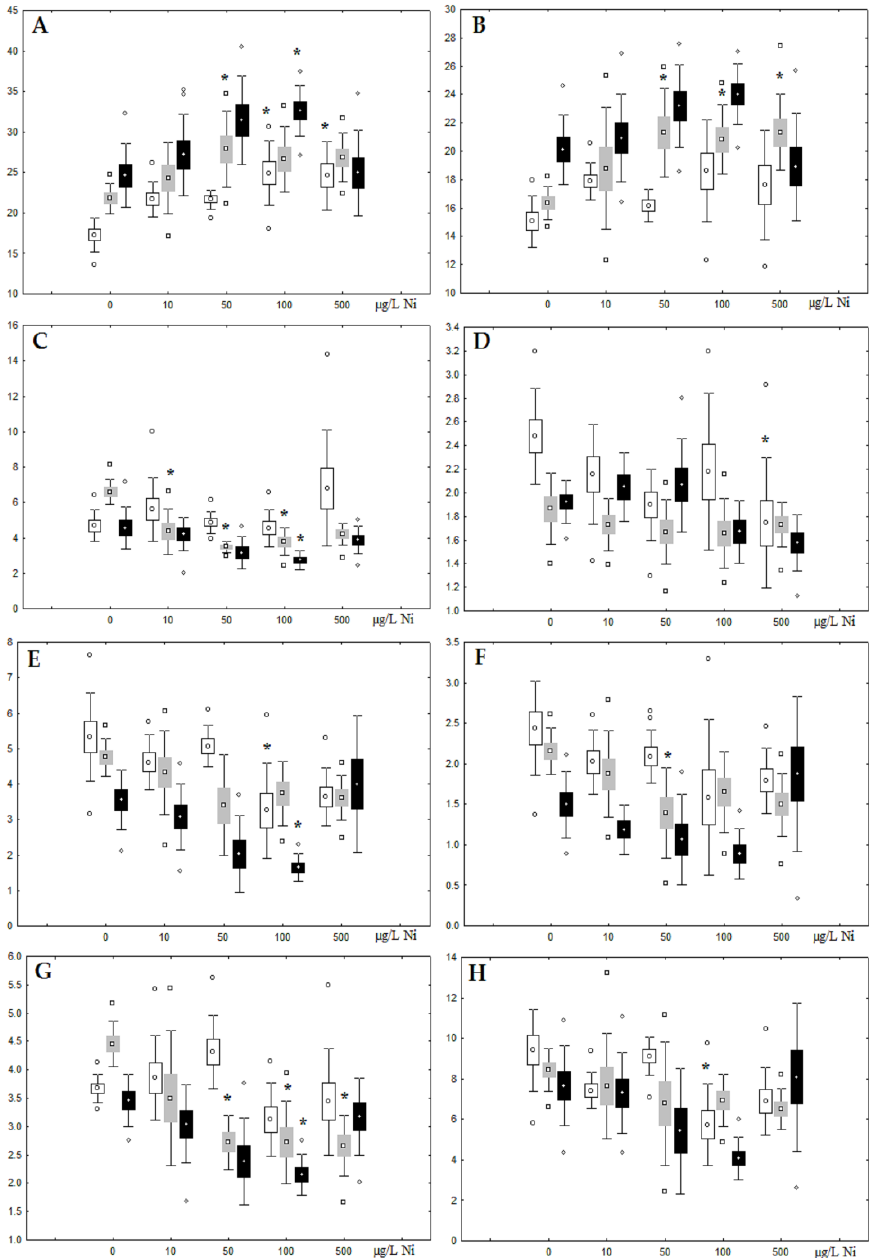
Figure 6. Changes in some dominated fatty acids in phospholipids: ( A ) 16:0, ( B ) 18:0, ( C ) 18:1n-9, ( D ) 20:1n-9, ( E ) 20:5n-3, ( F ) 22:6n-3, ( G ) 18:2n-6 and ( H ) 20:4n-6 in triacylglycerols of digestive glands of A. cygnea under experimental nickel effects: white box – day 1 of the experiment; grey box – day 3 of the experiment; black box – day 7 of the experiment. * – significant results in comparison with control (0 µg/L Ni). Differences were estimated using the nonparametric Kruskal – Wallis test, p < 0.05.